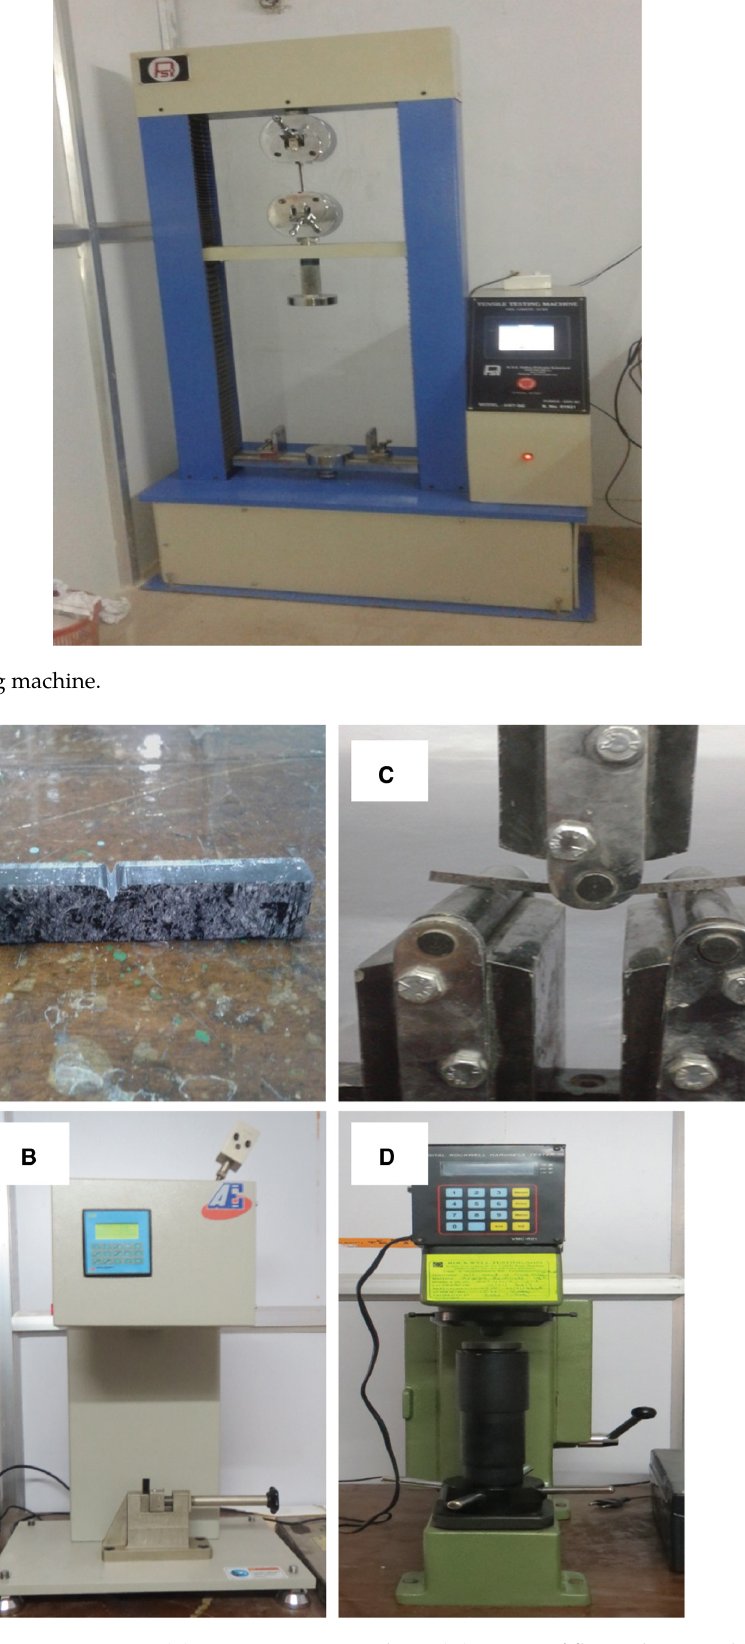
Figure 2: (A) Specimen for impact testing, (B) Impact testing machine, (C) Set-up of flexural test, and (D) Digital Rockwell hardness testing